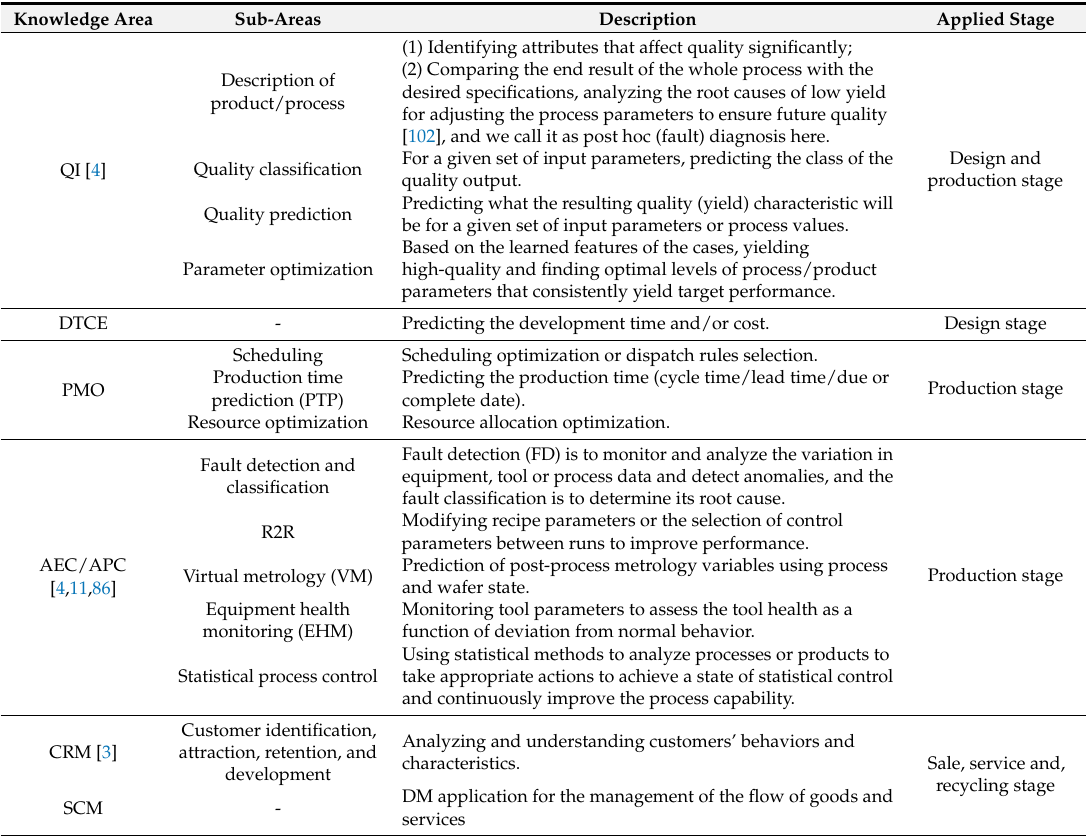
Table 8. The knowledge areas of DM application in the electronics